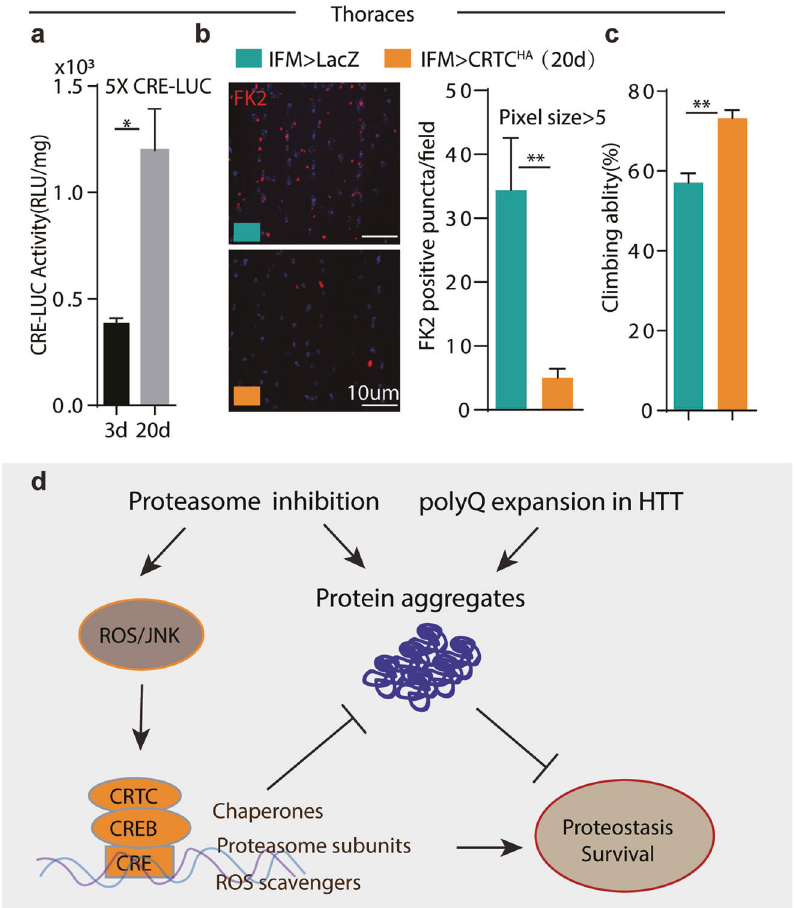
Fig. 7 CRTC overexpression suppresses protein aggregates accumulated in aged muscles. a CRE-Luc activity in thoraces increased during aging. LUC activity at 3d and 20d-old thoraces were compared. n = 6 for each condition. Student ’ s t -Test for statistical analysis. * P < 0.05. Genotype: 5xCRE-LUC. b , c Age associated FK2 positive aggregates were ameliorated by CRTC overexpression. FK2 positive aggregates in 3d and 20d-old muscles were quanti fi ed. Representative confocal images were shown on the left ( b ). FK2 positive aggregates with pixel size bigger than 5 were quanti fi ed on the right ( c ). Student ’ s t-test for statistical analysis. ** p < 0.01. Genotypes: IFM-Gal4; UAS-RFP or IFM-Gal4; UAS- CRTC-HA . d CRTC/CREB functions downstream of ROS/JNK pathway as a sensor to suppress proteotoxic stresses. Genetical or pharmacological inhibition of proteasome causes CREB activation through ROS/JNK cascade in fl ies. Together with CRTC, CREB promotes protein folding and proteasome activity by increase transcription of redox regulators, such as molecular chaperones, proteosome subunits, and ROS scavengers. Hence, increasing CRTC/CREB activity reduces protein aggregates and rescues pathogenesis of protein conformational disorders, such as Huntington ’ s disease (HD). CRTC cAMP-regulated transcriptional co-activators, CREB cAMP Responsible Element Binding Protein, CRE cAMP responsive